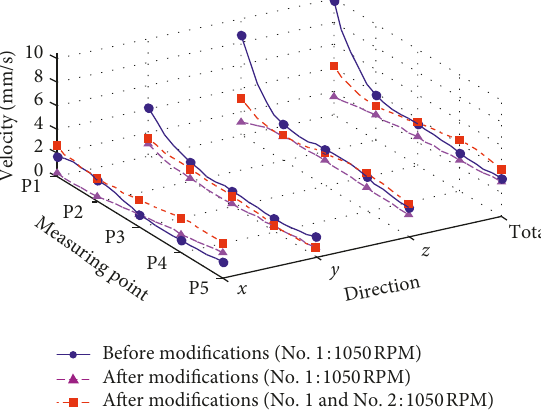
Figure 12: Comparison of velocity before and after modifications.